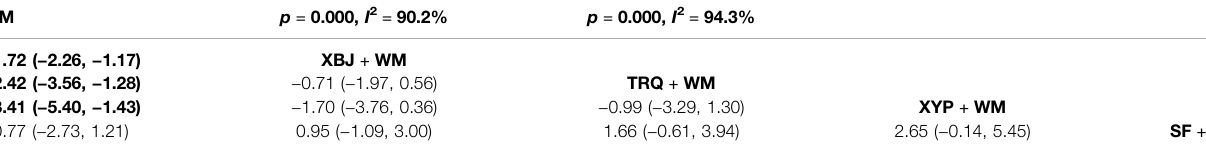
Signi fi cant effects are printed in